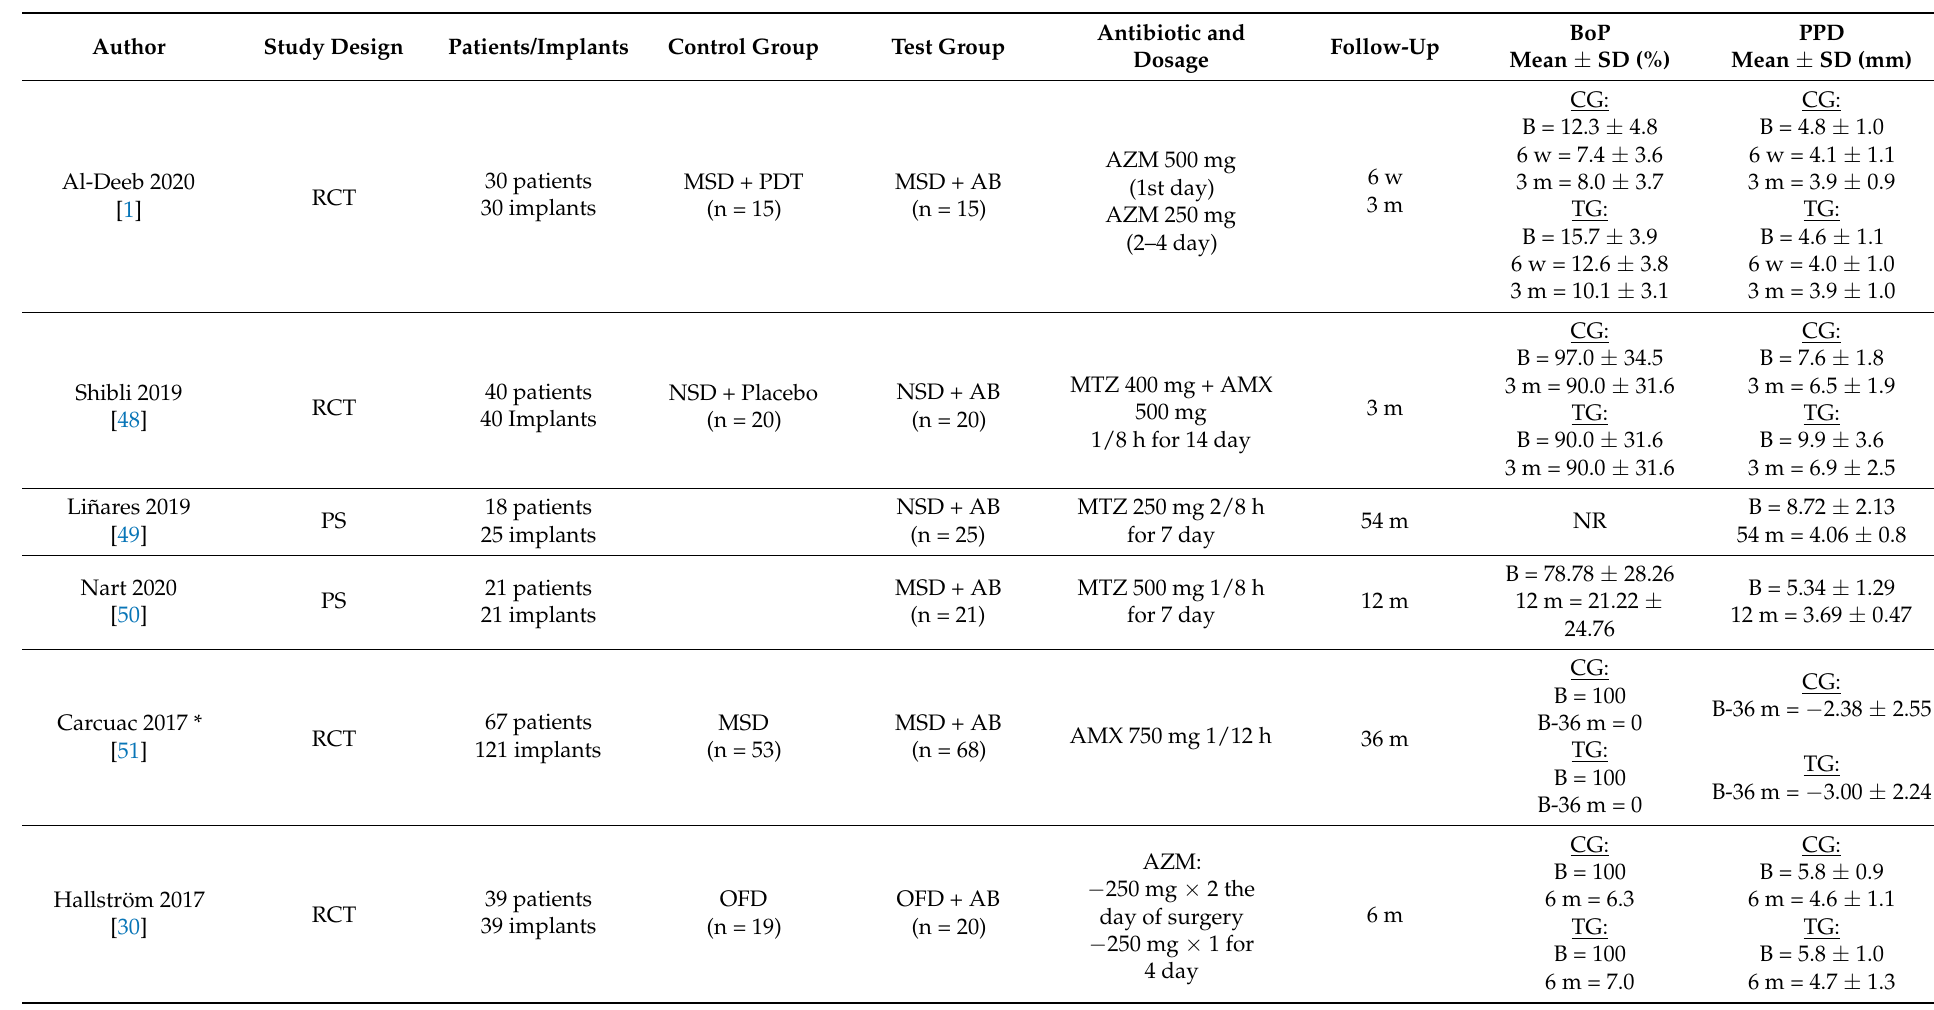
Table 2. Characteristics of the included studies. Primary outcomes investigated were BoP and PPD reduction in the treatment of peri-implantitis when using systemic